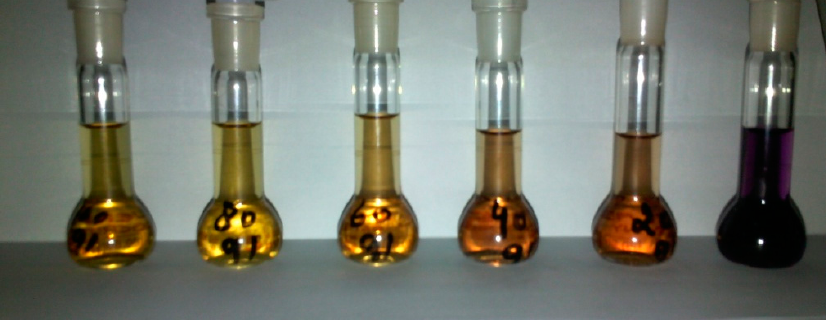
Figure 6. Naked eye detection of DPPH radical scavenging activity of compound 1 . Sample flask to the right-hand side contains free DPPH, and concentration of compound 1 increases in the preceding flasks from right to left.